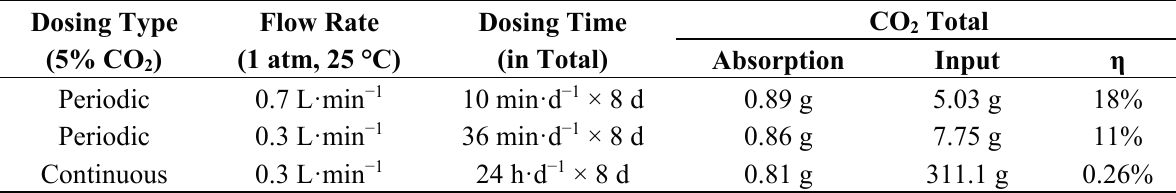
Figure 1. Daily chlorophyll content of the D. salina cultures with different dosing conditions. The cultures with 0.7 L·min − 1 of periodic dosing were conducted in parallel, as were the control cultures. Therefore, the daily chlorophyll content for these two dosing conditions shown in this graph is the average value, with the error bars given separately. Table 1. Comparisons of CO 2 capture efficiency for different dosing